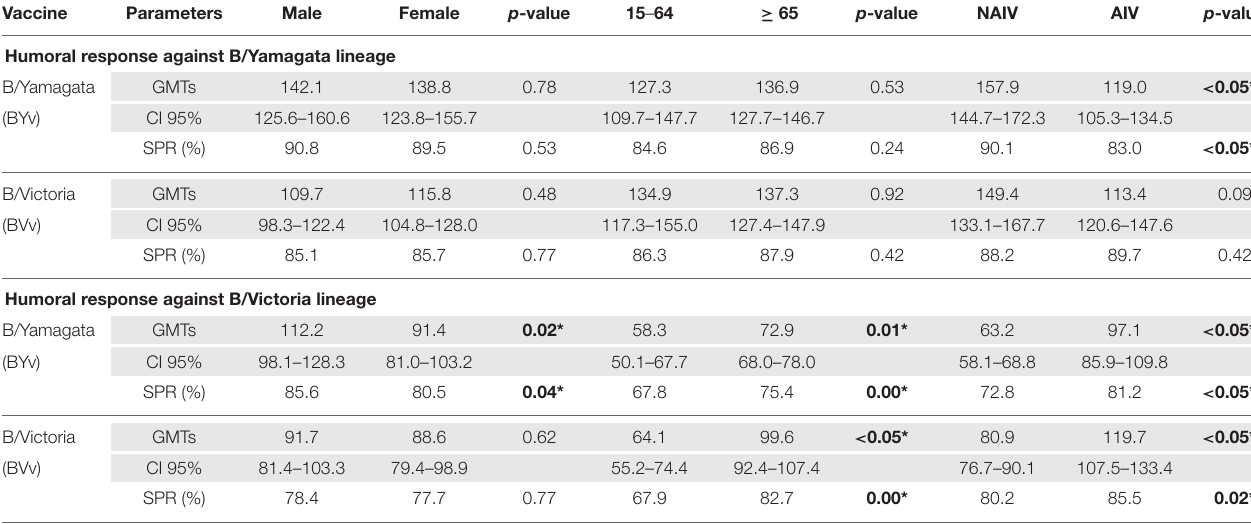
TABLE 2 | Humoral status before vaccination against B/Yamagata lineage and B/Victoria lineage in all groups. Vaccine